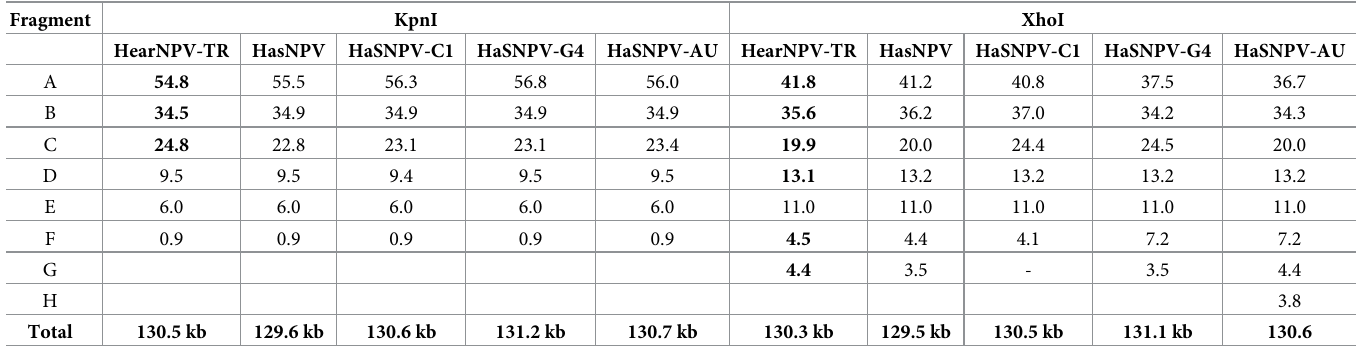
Table 2. Restriction endonuclease profile of HearNPV-TR, HasNPV, C1, G4, AU strains as per KpnI and XhoI enzymes. Fragment KpnI